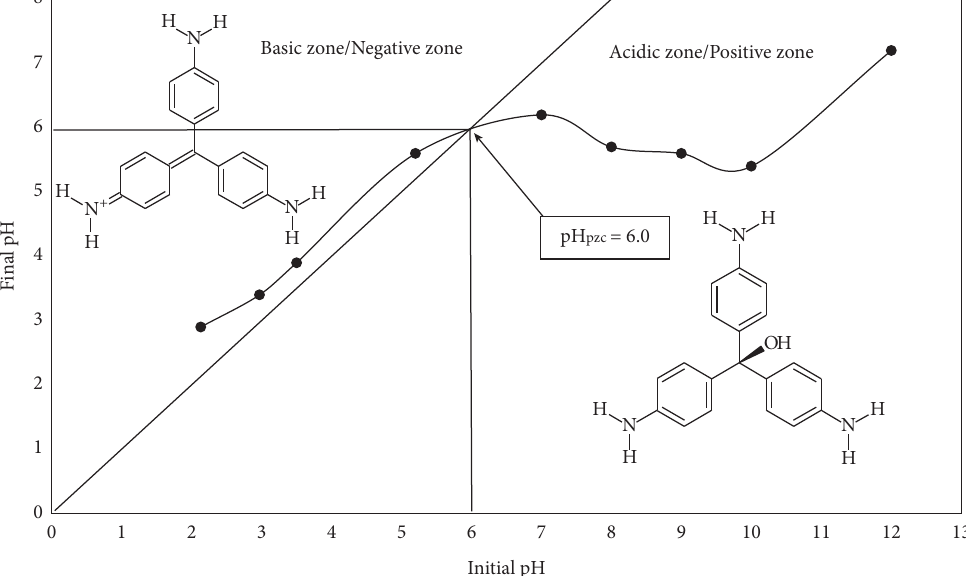
Figure 2: pH pzc graph for HAB (by pH drift